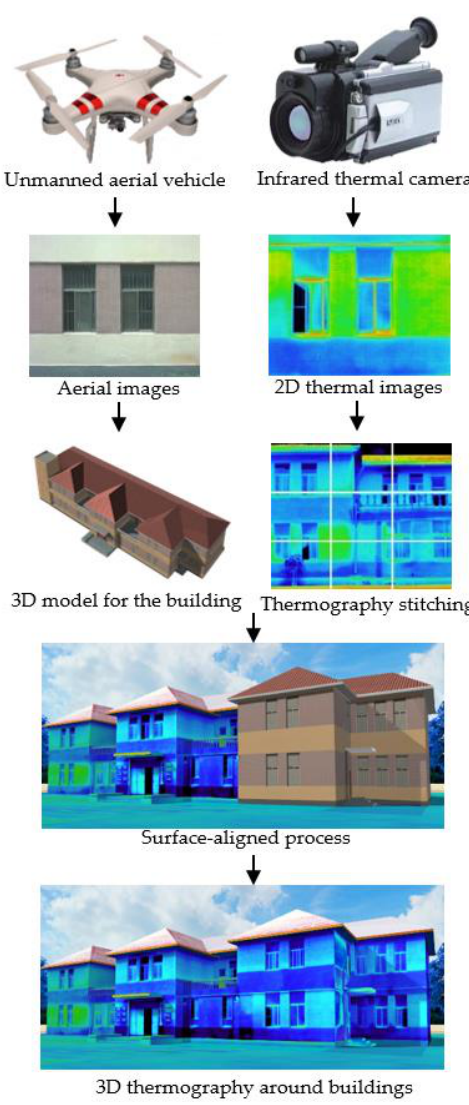
Figure 1. Processing flow of 3D thermography preparation.